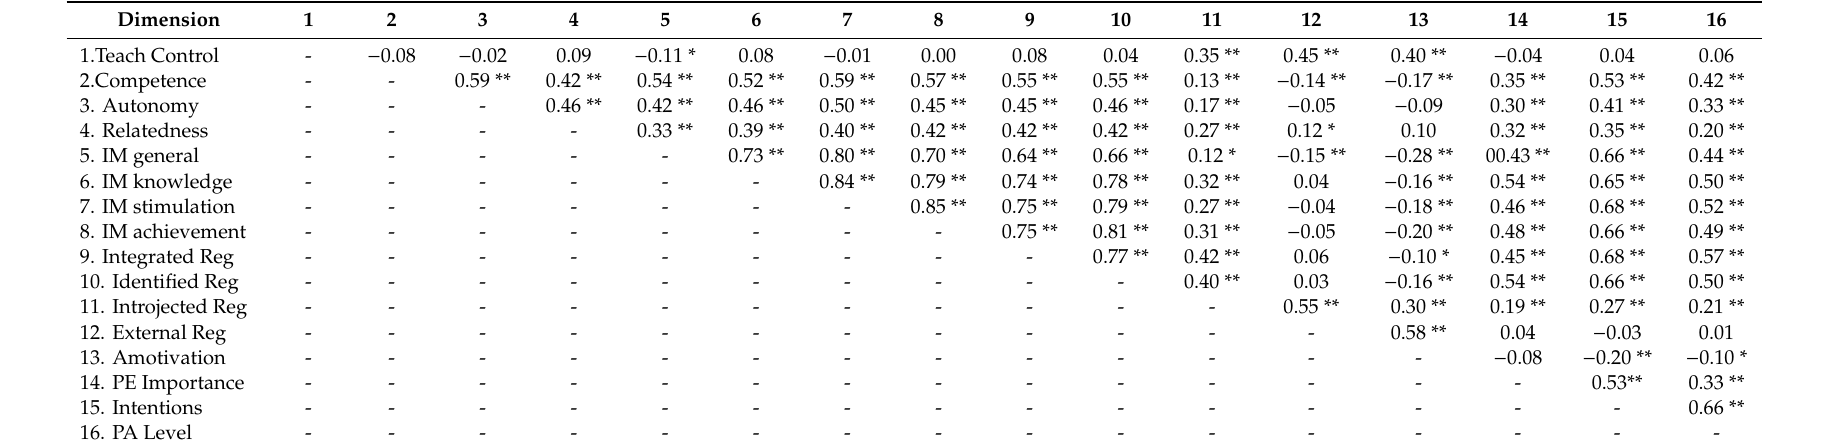
Table 2. Correlations among study